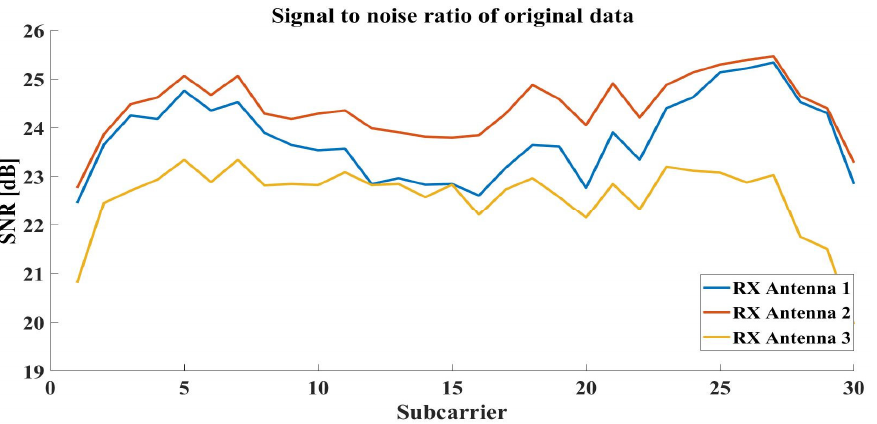
Figure 2. Signal ‐ to ‐ noise ratio of different antennas. Figure 2. Signal-to-noise ratio of different